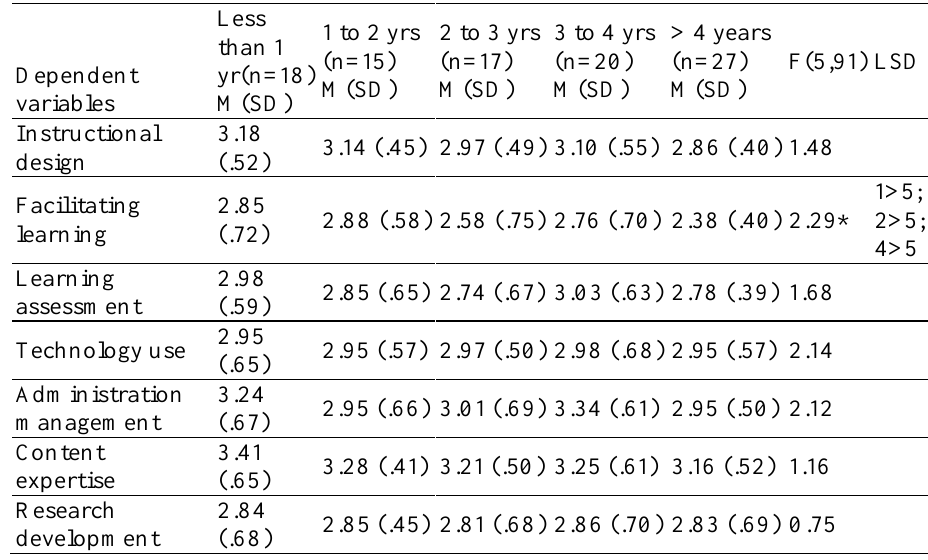
Practice of Different Experiences of Online